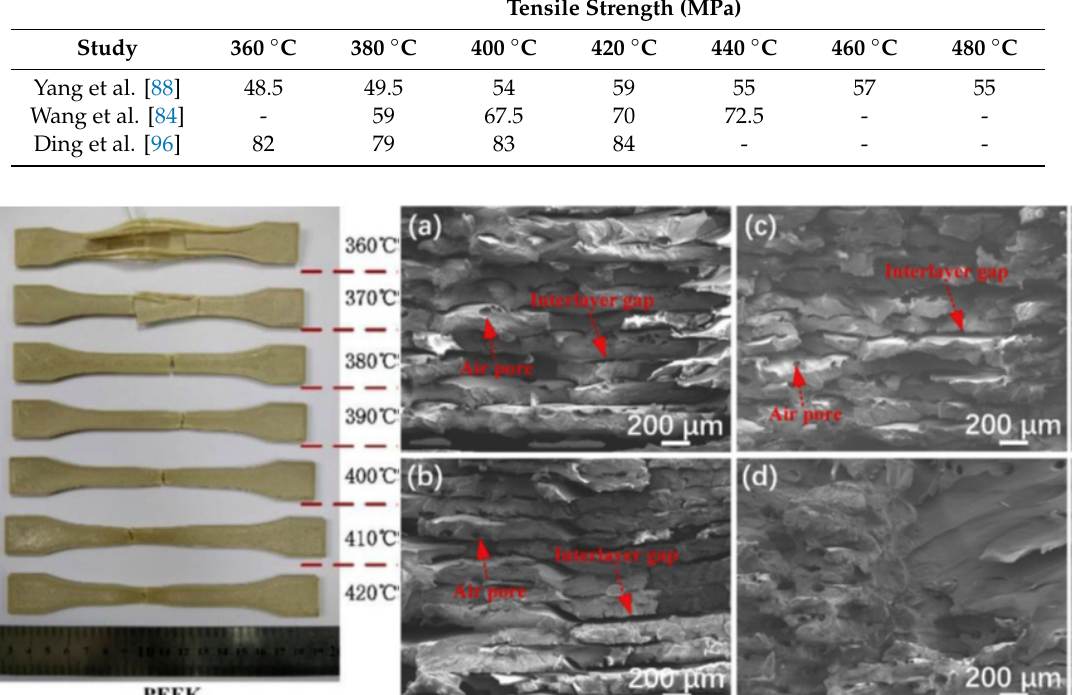
Figure 11. Morphology of the PEEK tensile samples printed at different nozzle temperatures (left), and SEM micrographs of tensile fracture surface of printed PEEK at different printing temperatures: ( a ) 370 °C, ( b ) 380 °C, ( c ) 390 °C, and ( d ) 420 °C [96].